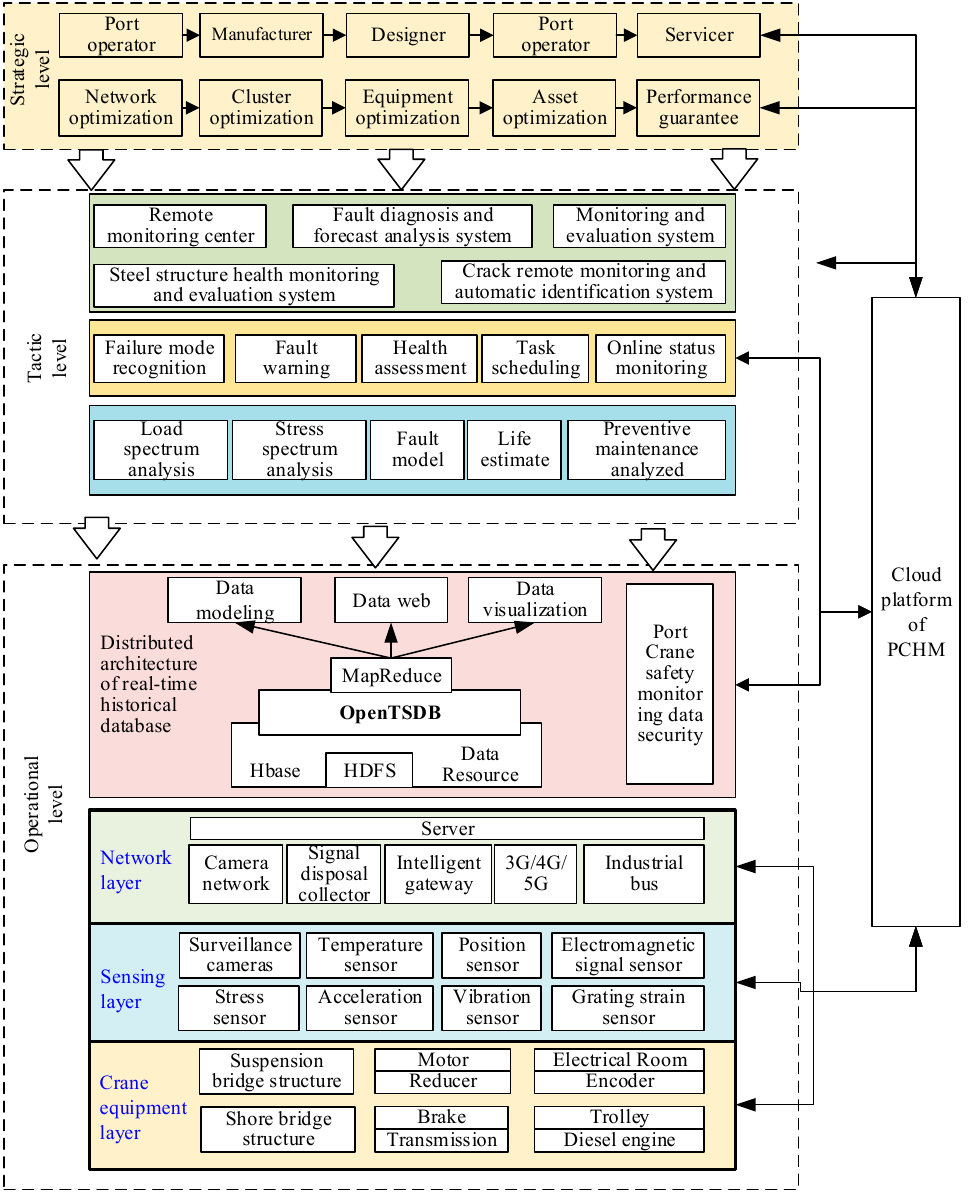
Figure 5. Application of the innovative CHMS framework.